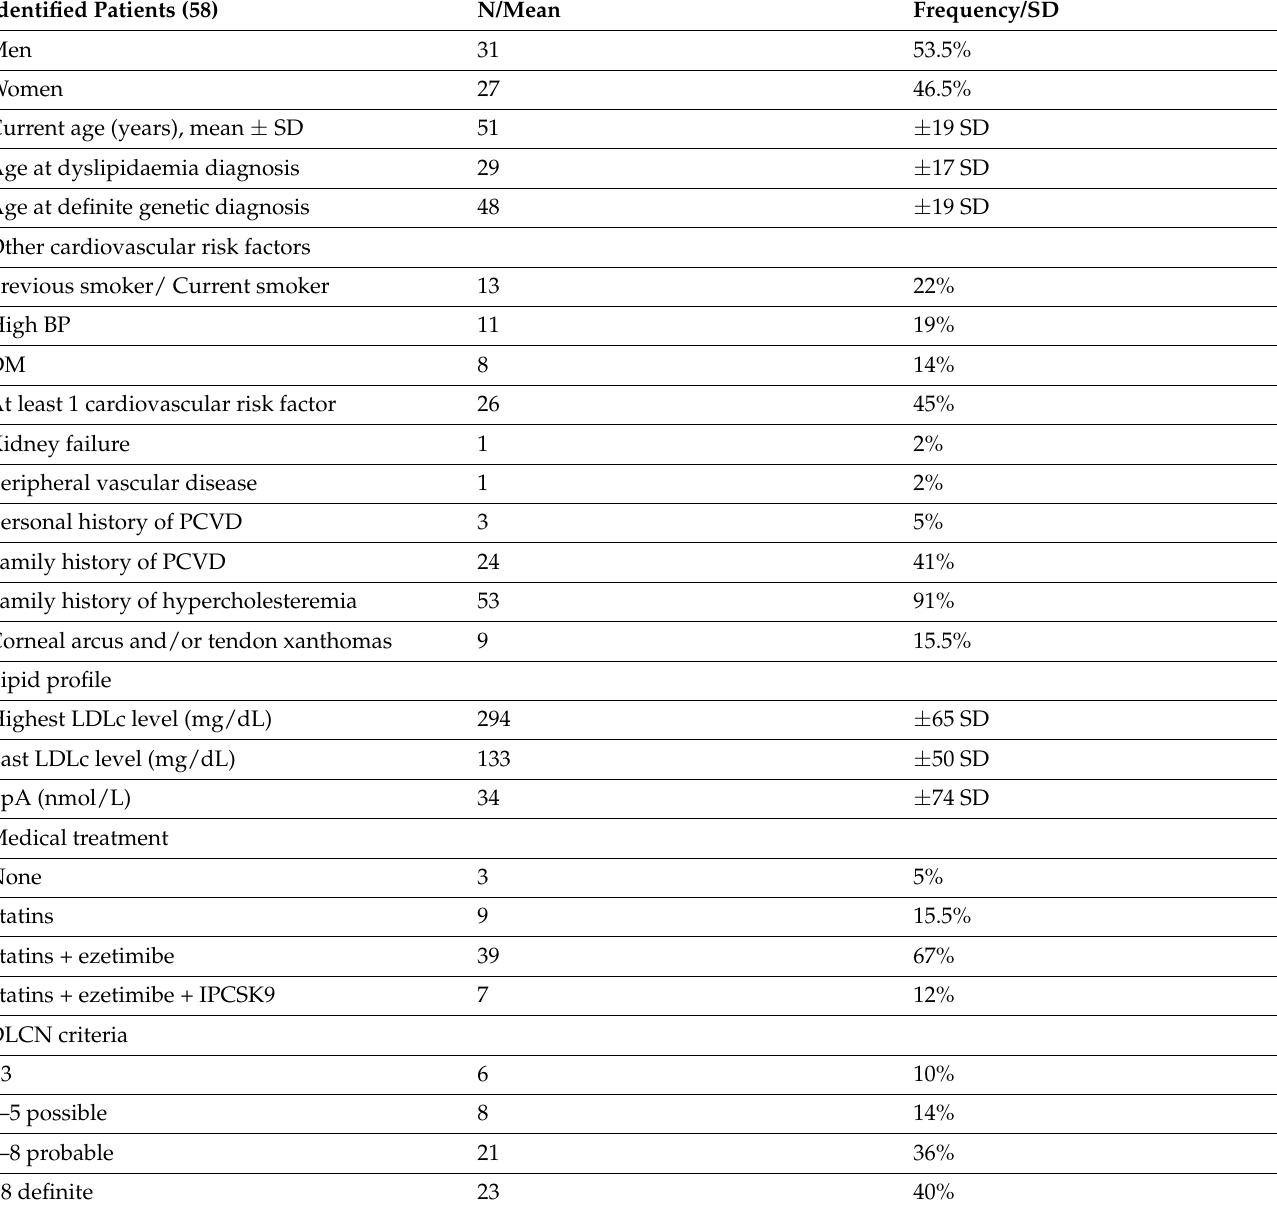
Table 2. Clinical characteristics of patients with genetic diagnosis of